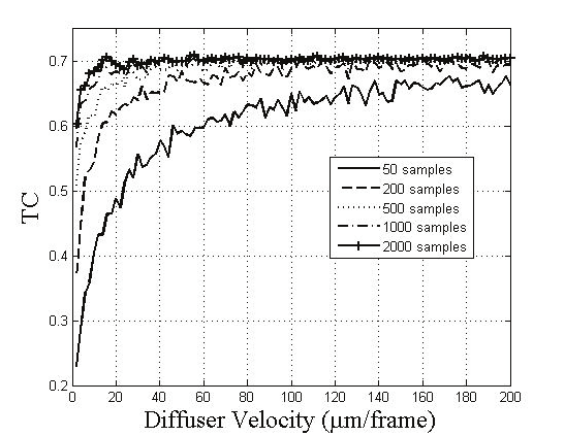
Fig. 3 Temporal Contrast desdriptor ( TC )